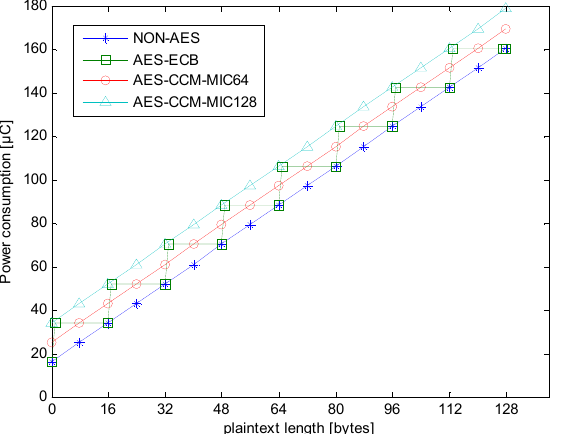
Figure 7. Transmission power consumption of different encryption types.